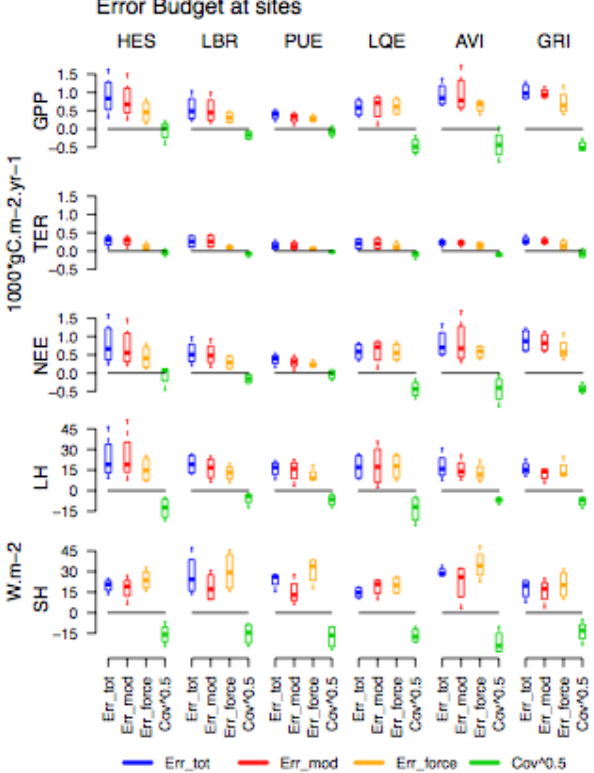
Fig. 9. Box plot of error estimation across 4 time scales at each site Figure 9 147 during peak growing season. The symbols of boxplots are defined the same as in Fig.